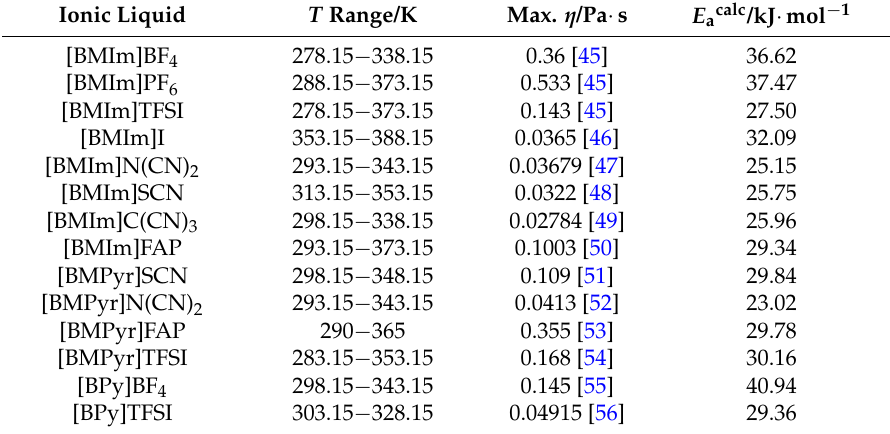
Table 1. The range of temperatures ( T ) of the fitted experimental viscosities, experimental viscosities ( η ) at the lowest temperature of the corresponding temperature range, and the activation energies ( E acalc ) calculated from the experimental viscosity–temperature dependence using Equation (8). Ionic Liquid T